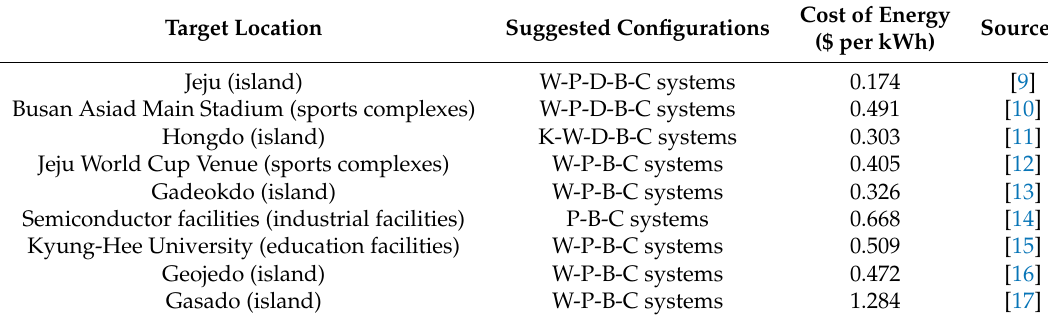
Table 1. Summary of prior feasibility studies of renewable energy facilities conducted in South Korea (W: Wind turbines, P: photovoltaic (PV) arrays, D: Diesel generators, B: Battery units, C: Converters, K: Kerosene